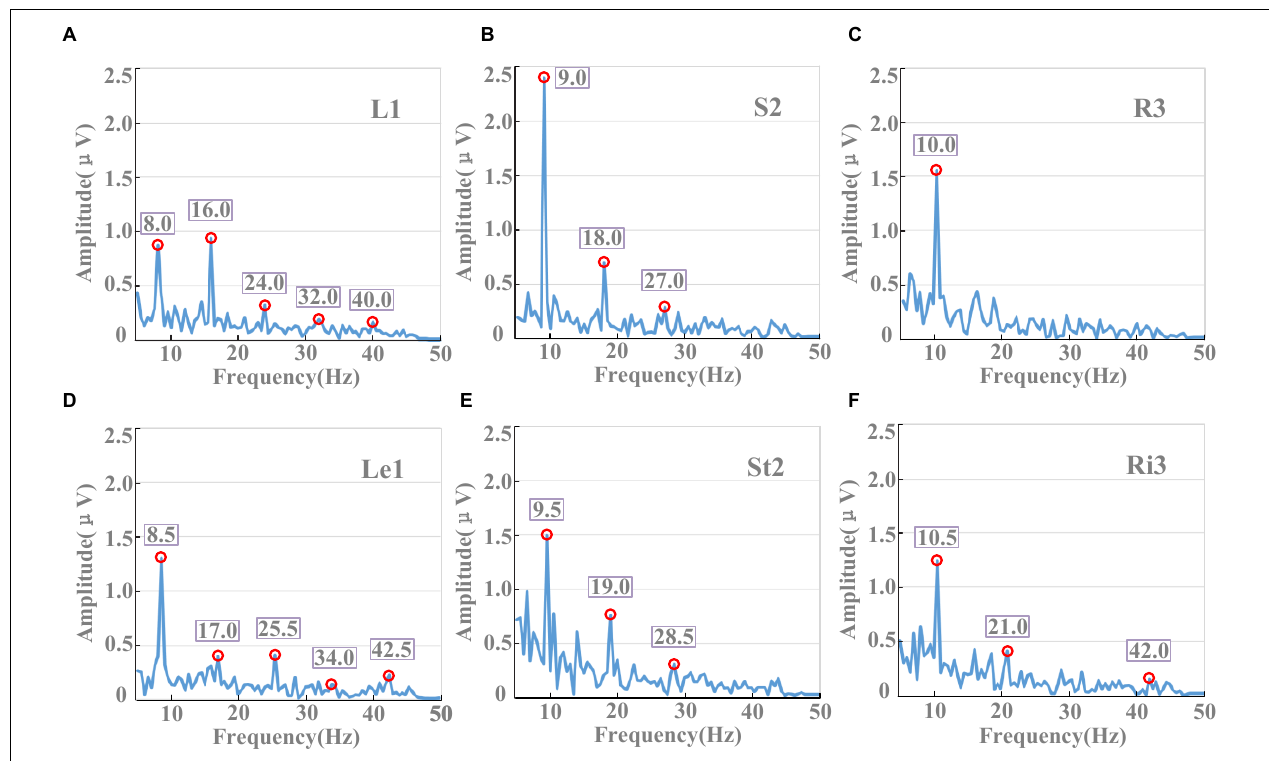
FIGURE 6 | Spectra diagram from a subject (PO3). (A–F) Corresponded the targets of L1, S2, R3, Le1, St2, and Ri3, respectively.